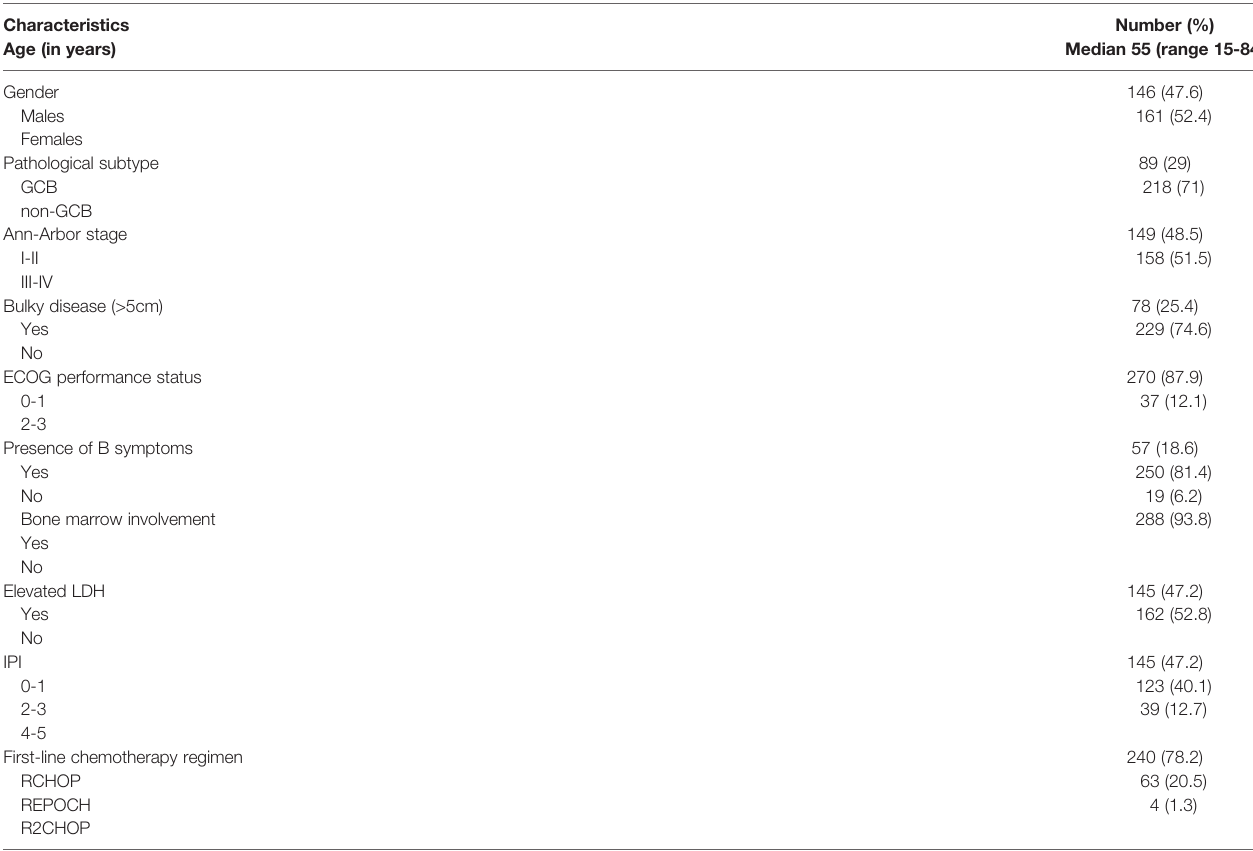
TABLE 1 | Baseline characteristics of DLBCL patients with frontline chemotherapy (n=307).